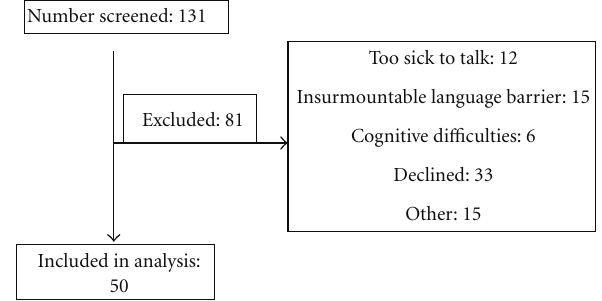
Figure 1: Screening and